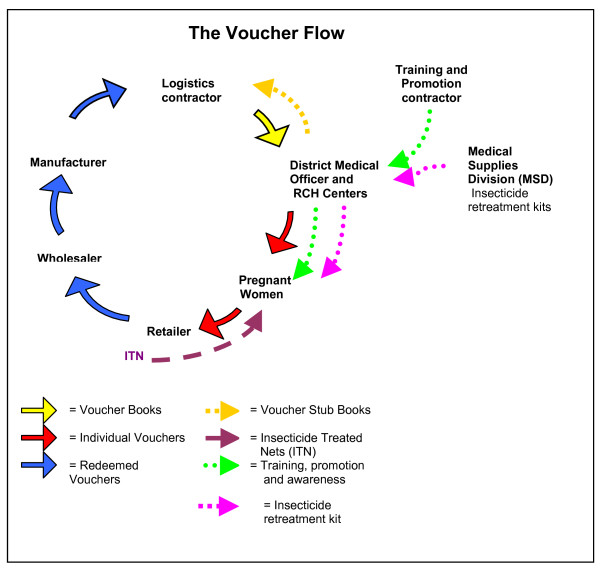
The voucher flow.